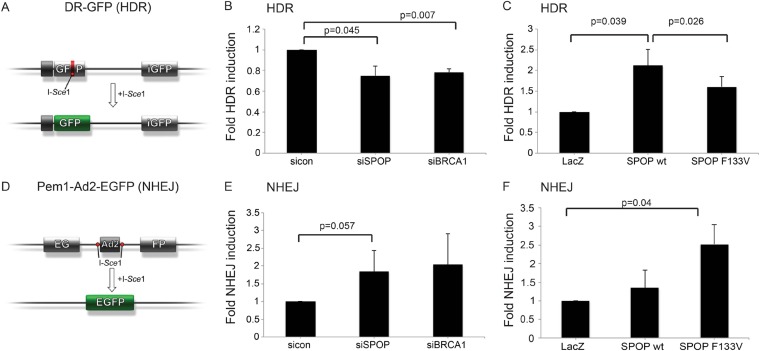
SPOP modulates DSB repair activity similar to BRCA1.(A) Schematic overview of the DR-GFP assay used to measure homology-directed repair (HDR) activity. (B, C) Analysis of the HDR-activity in HEK 293 cells with siRNA knockdown of SPOP or BRCA1 and ectopically expressing SPOP-wt or SPOP-F133V. (D) Schematic overview of the Pem1-Ad2-EGFP assay used to measure NHEJ-activity. (E, F) Analysis of the NHEJ-activity in HEK 293 cells with siRNA knockdown of SPOP or BRCA1 and ectopically expressing SPOP-wt or SPOP-F133V. All results are represented as s.e.m.